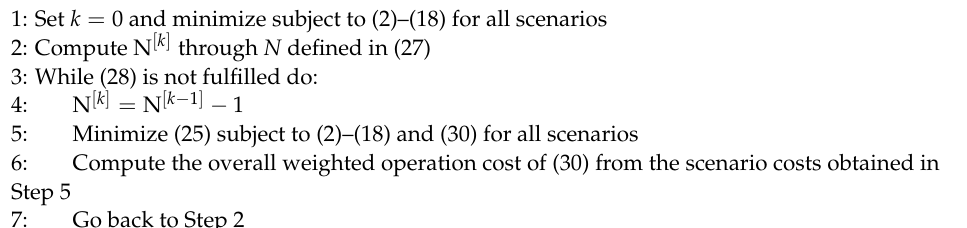
Algorithm 1. Decomposed iterative optimization